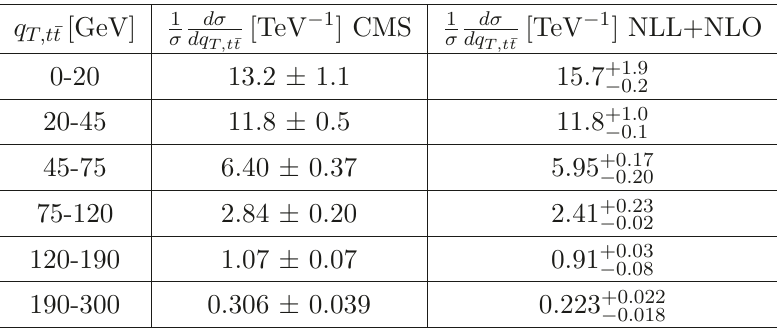
Table 2. The normalized q T distribution 1 /σ ( dσ/dq T ) of t ¯ t pairs in pp collisions at the LHC ( √ s = 8 TeV): comparison between CMS data (lepton+jets channels) [18] and NLL+NLO results. q [GeV] T,t ¯ t